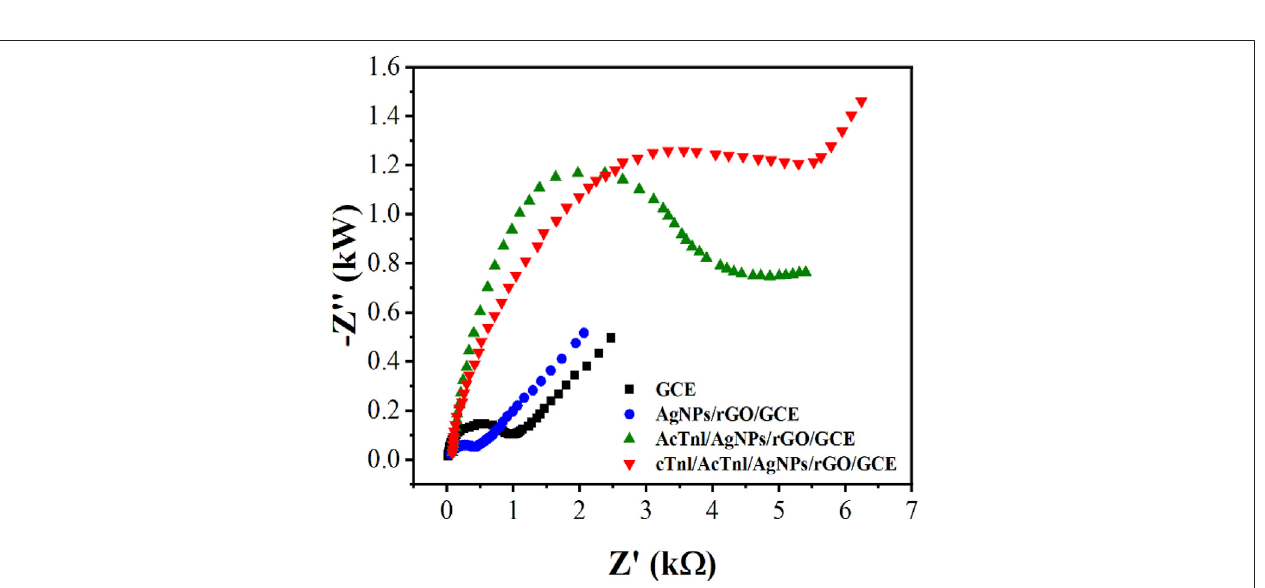
Frontiers in Chemistry |